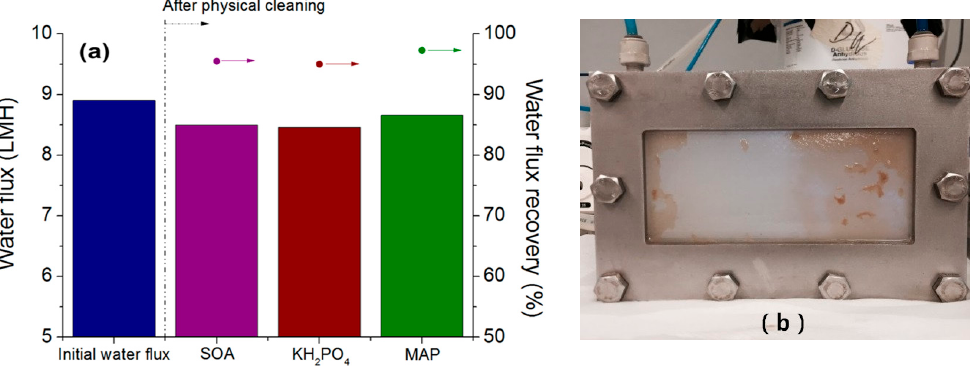
Figure 4. ( a ) Water flux recovery rates of different fertilizer draw solutions; and ( b ) fouled membrane surface.